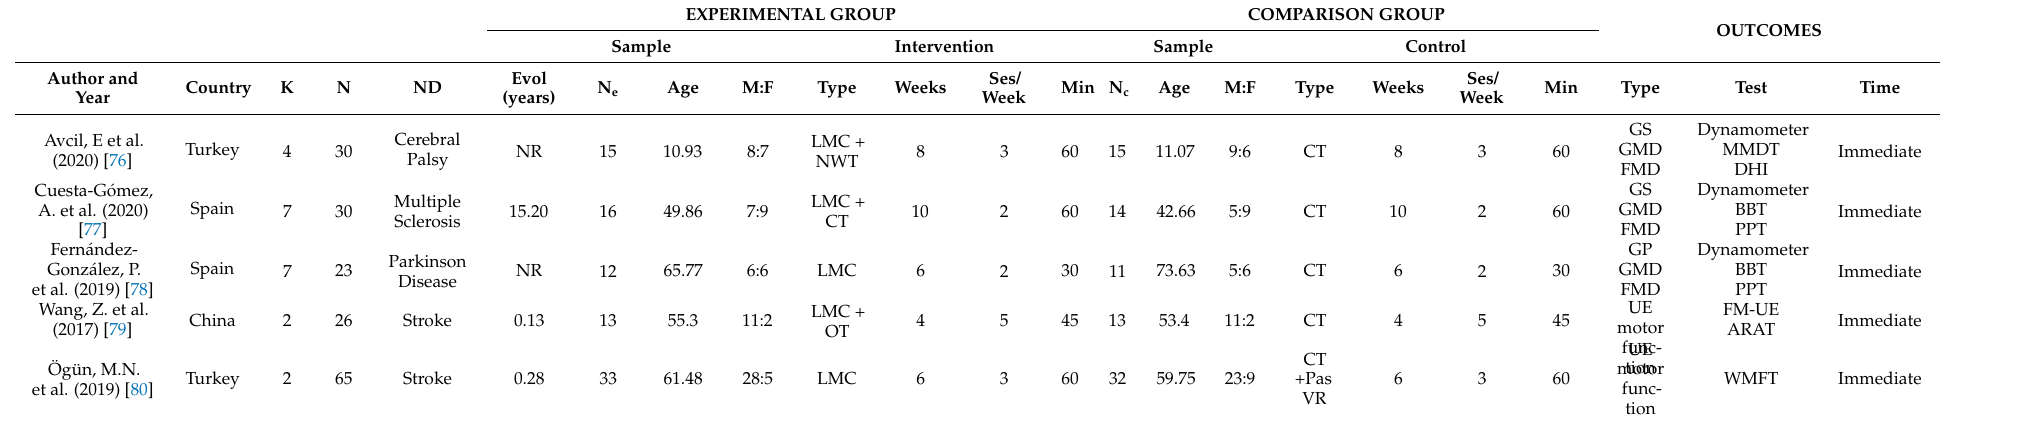
Table 2. Main characteristics of the studies included in the